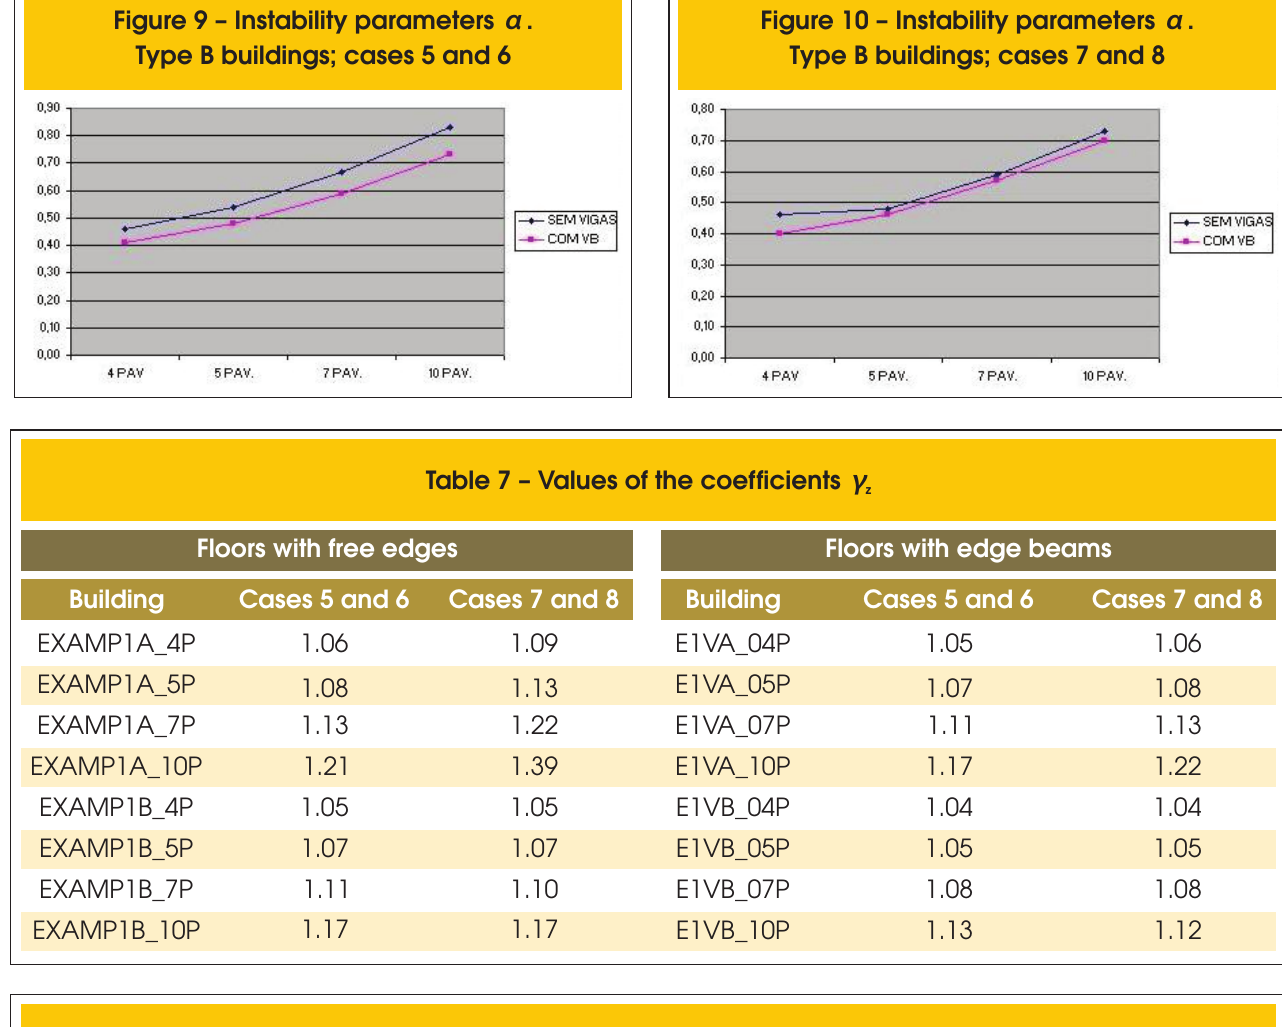
Figure 9 – Instability parameters α . Figure 10 – Instability parameters α .